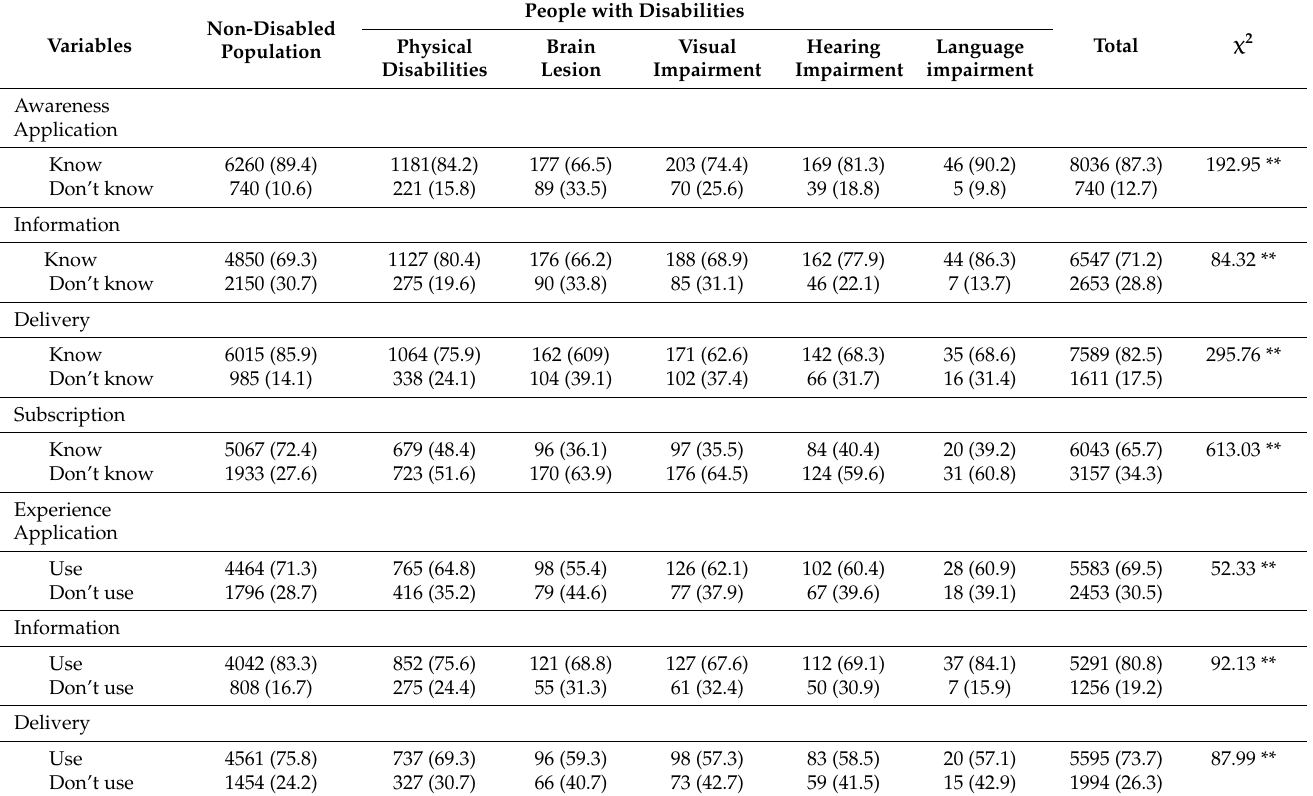
Table 4. Awareness and experience of COVID-19-related non-face-to-face